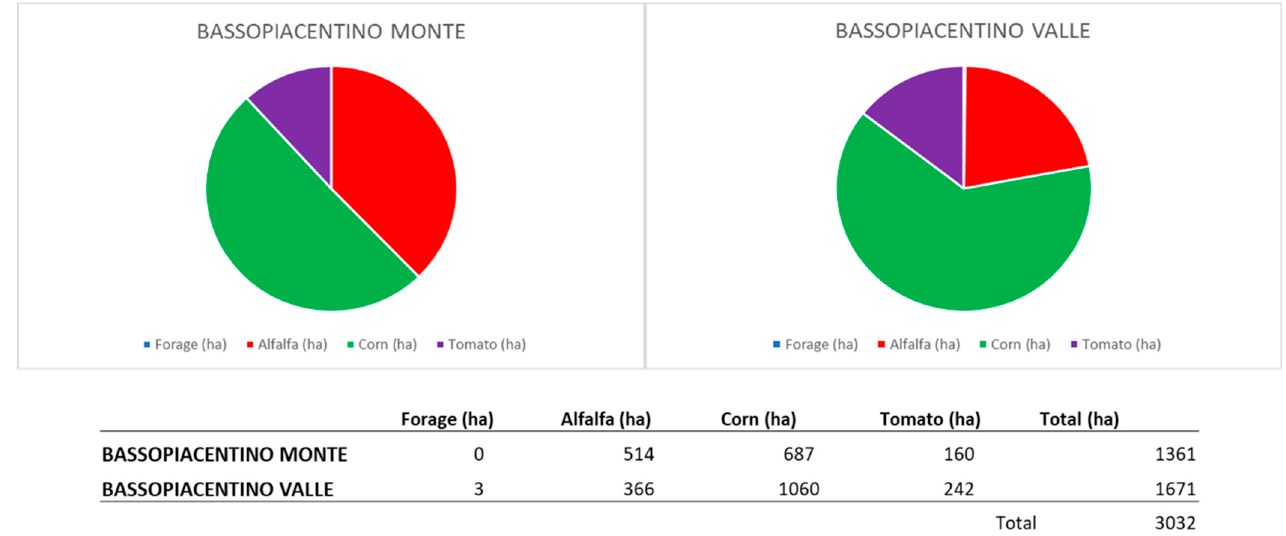
Figure A2. Land use.